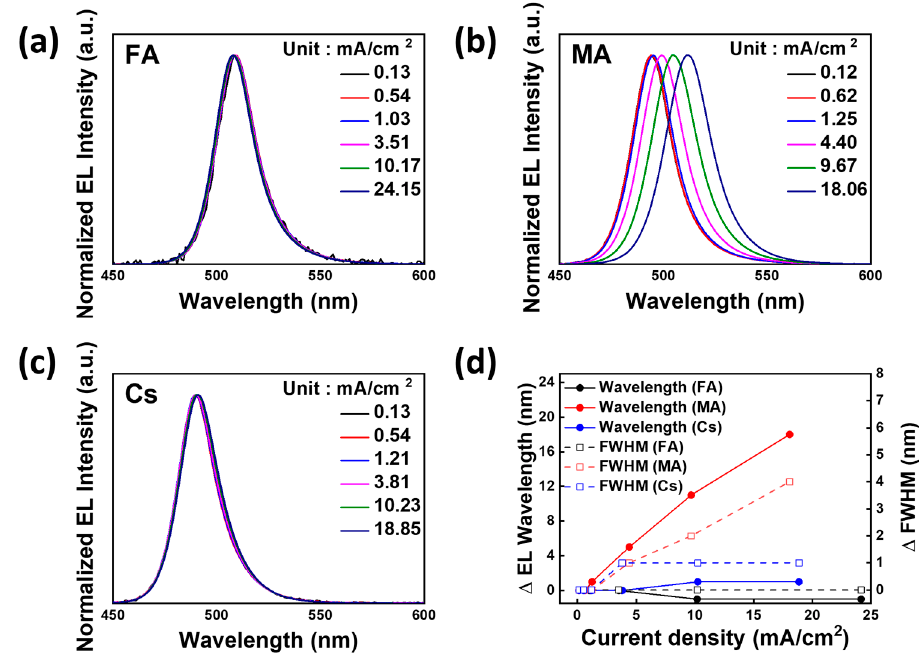
Figure 4. Electroluminescence (EL) spectrum of ( a ) FA-based, ( b ) MA-based, ( c ) and Cs-based quasi-2D PeLEDs at various applied voltages. ( d ) Changes in the EL wavelength and full width at half-maximum (FWHM) of FA, MA, and Cs-based quasi-2D PeLEDs.